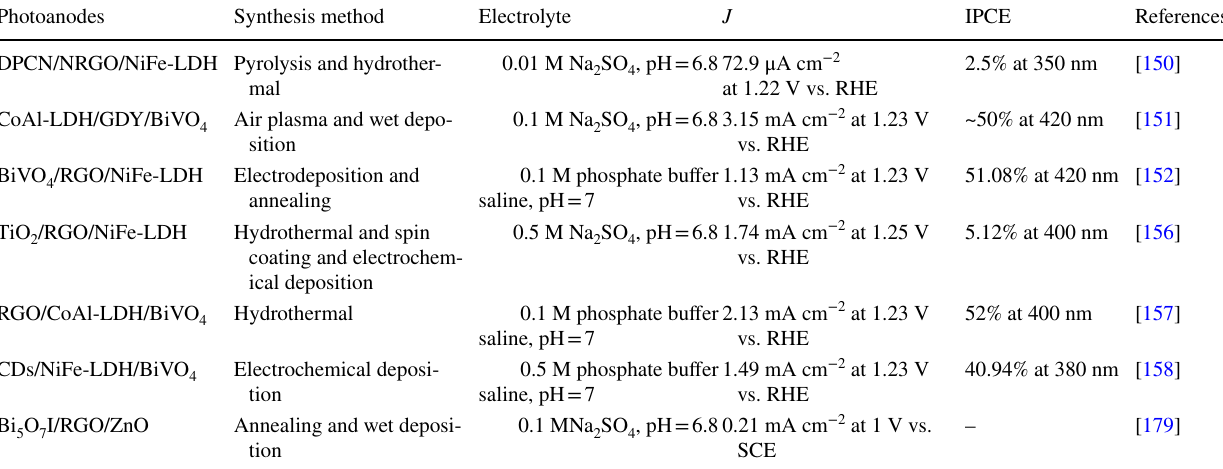
Table 2 Comparison of PEC-OER activity of various 2D photoanodes